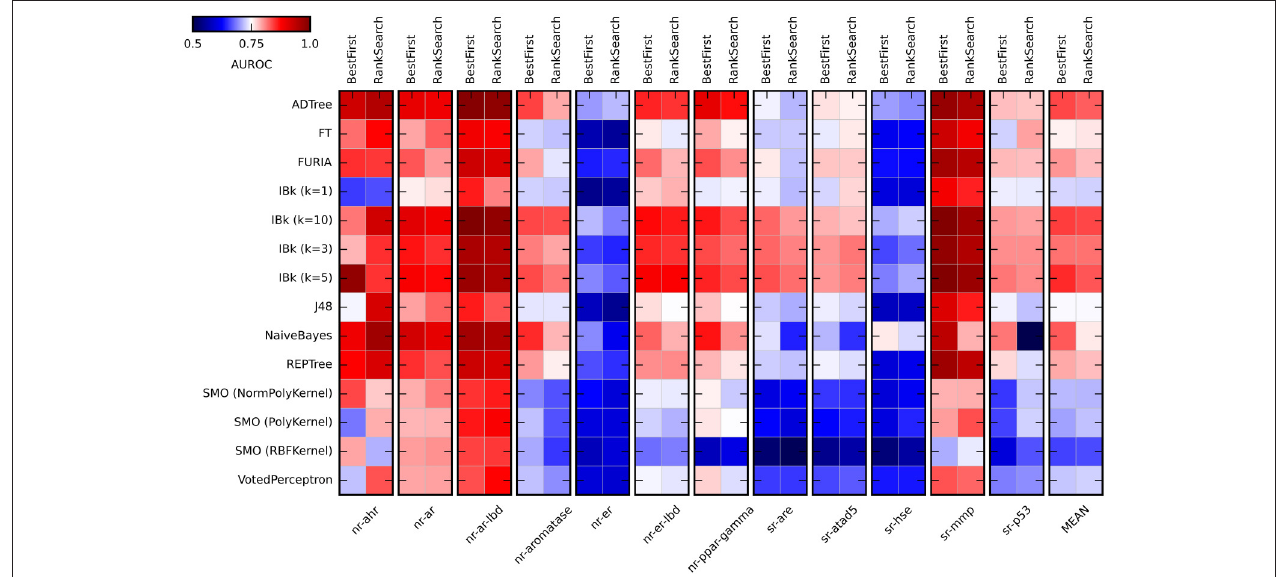
FIGURE 2 | Heat maps presenting results of the initial methods evaluation. Color coded AUROC values are presented for 14 classifiers (Y axis) in combination with two attribute selection methods (top X axis), grouped by the target (down X axis). Additional group presenting mean AUROC values is added for classifiers comparison.